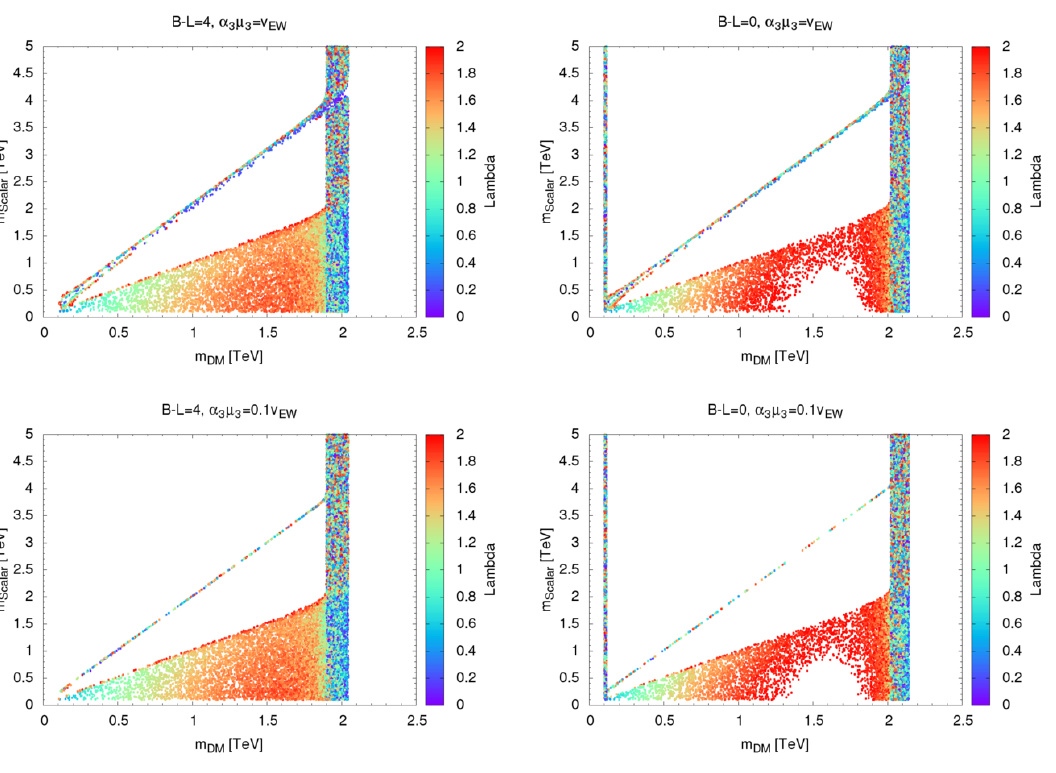
Figure 4 . Scatter plots in m DM - m scalar plane showing the allowed parameter space satisfying the relic density. We vary (cid:21) in the range 0 to 2 in each panel. The left panel is for B (cid:0) L = 4 case, whereas the right panel is for B (cid:0) L = 0 case. The upper (lower) panels are for (cid:11) 3 (cid:22) 3 = v EW (0.1 v EW ). In all the panels, we take M W = 6 TeV, M Z = 7 : 14 R R